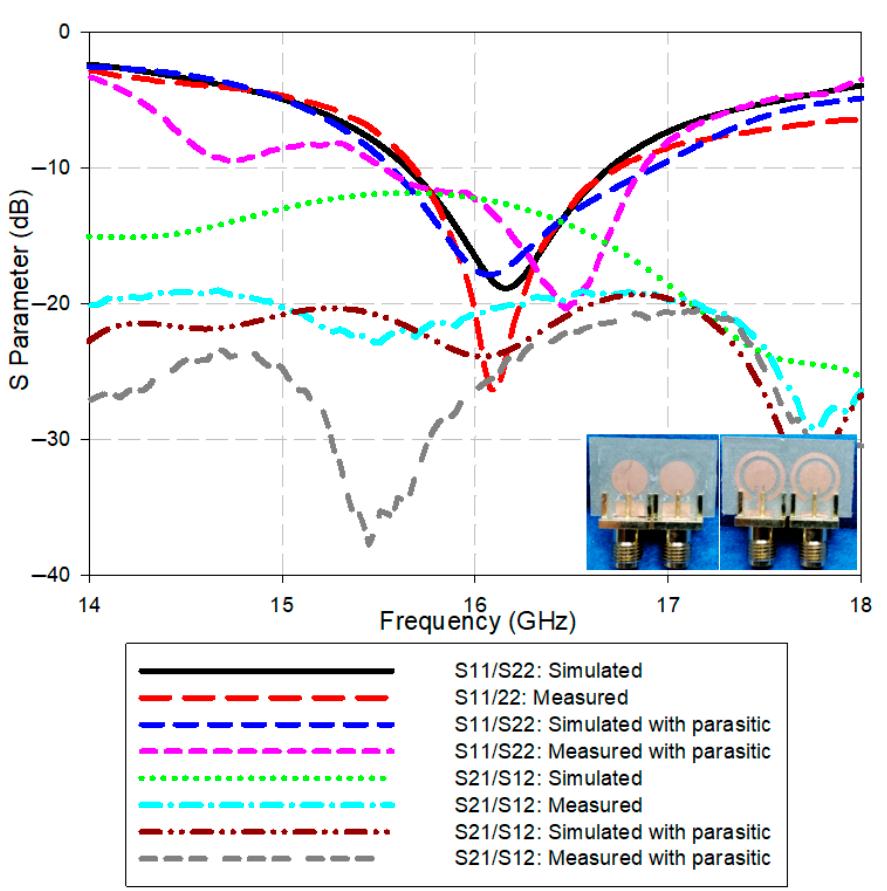
Figure 11. Measurement and simulation results of S-parameter for Antenna 1 and Antenna 2.